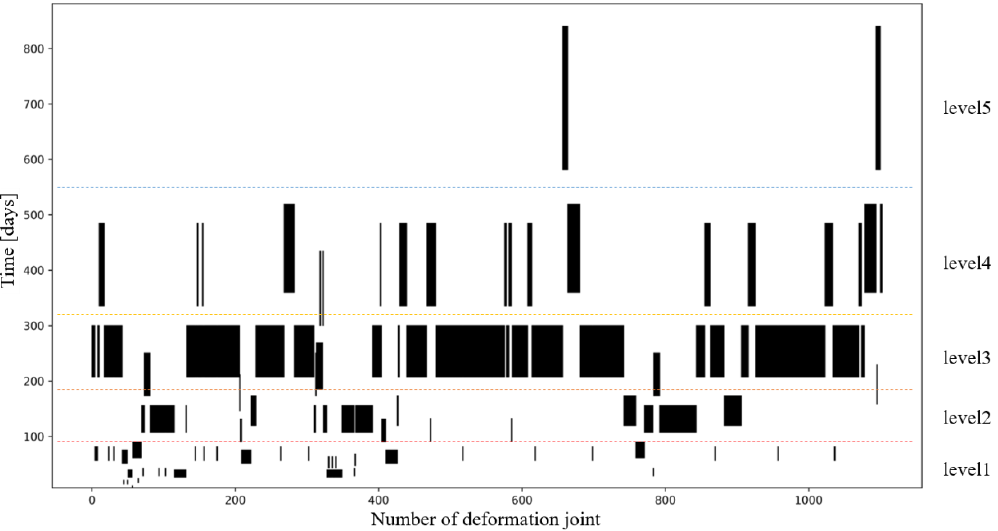
Figure 10. Estimated results in the wear-out